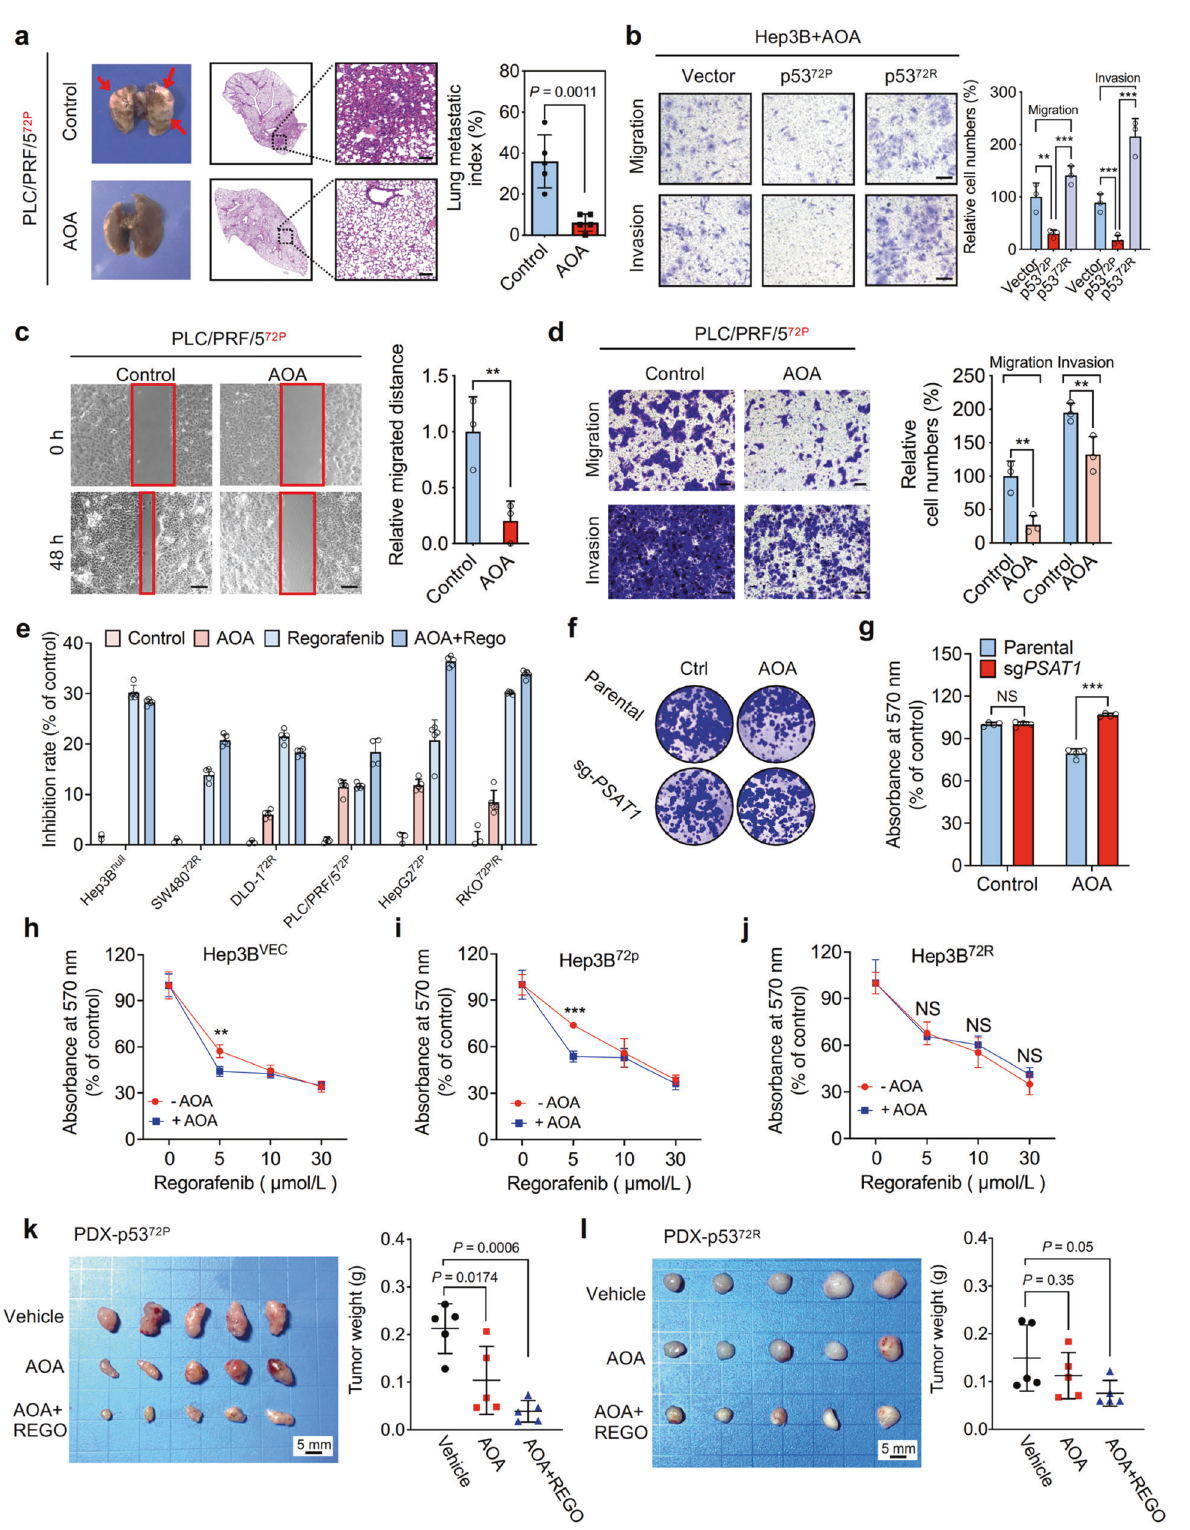
Primary antibodies are listed below: anti-p53 (Cell Signaling Technology, cat#9282), anti- β -actin (Santa Cruz Biotechnology, cat#sc-69879), anti-PSAT1 (Novus Biologicals, NBP1-32920), anti- FLAG (Cell Signaling Technology, cat#14793S), anti-PGC-1 α (Novus